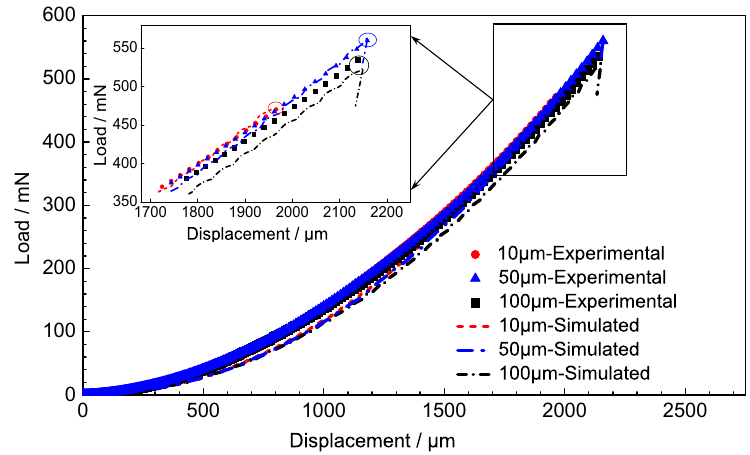
Figure 13. Comparison between experiments and simulation of instrumented indentation in the 0.1 mmA shot-peened IN718